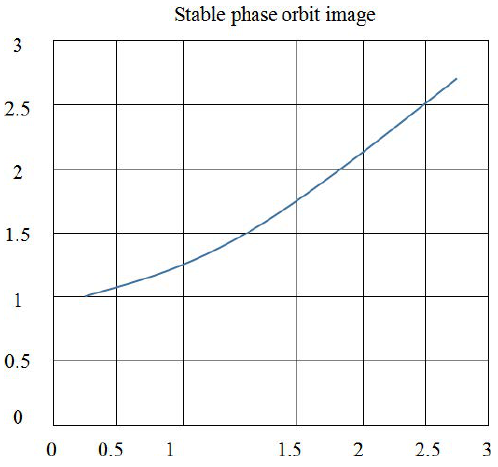
Fig. 2 αβ > k 1 phase track line